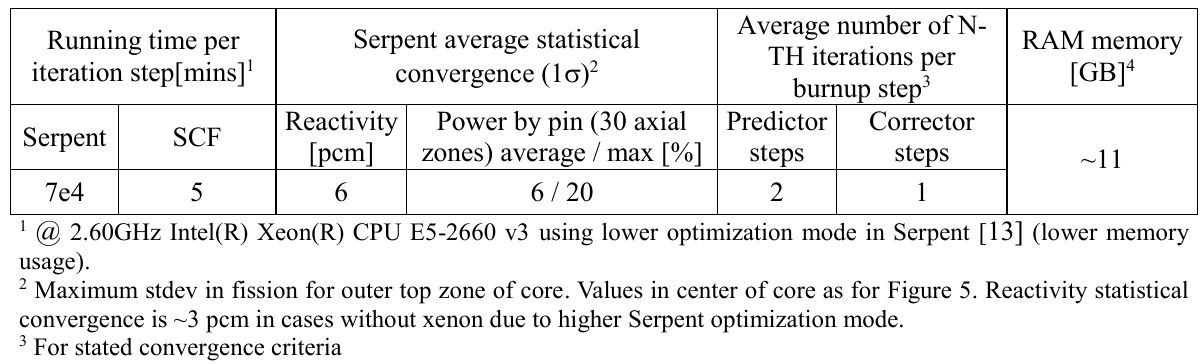
Table IV: Average running aspects of the proposed coupled